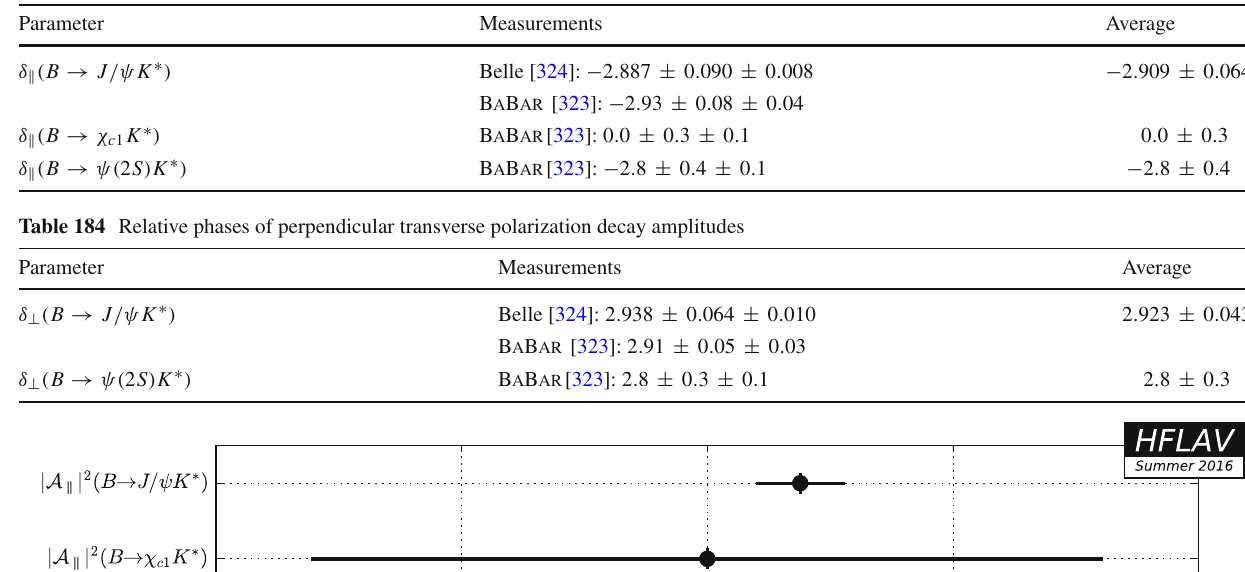
Table 183 Relative phases of parallel transverse polarization decay amplitudes